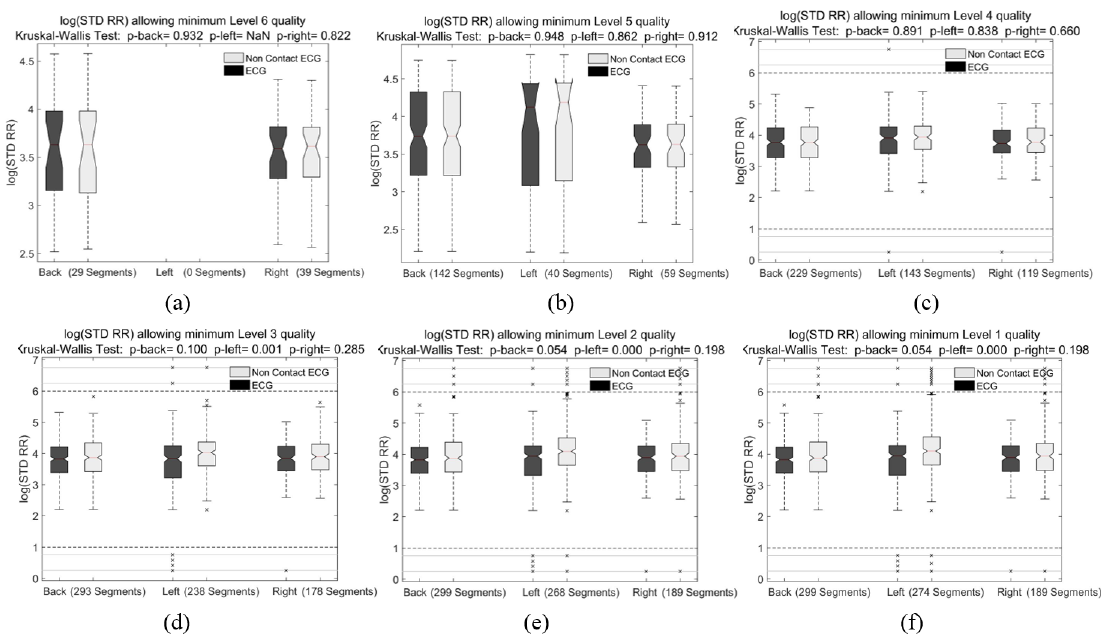
Figure 7. Results of extracting the standard deviation of the RR intervals from all the 30-s segments in the best channels per measurement. The extracted feature from ccECG and reference ECG are presented, together with Kruskal-Wallis Test p -values. The boxplots present the results of including the signal segments with a Visual Quality of Level ( a ) 6; ( b ) 5 and 6; ( c ) 4 to 6; ( d ) 3 to 6; ( e ) 2 to 6; ( f ) 1 to 6. Kruskal-Wallis Test results show that when including the signals of quality 3 and lower, the p value drops significantly.